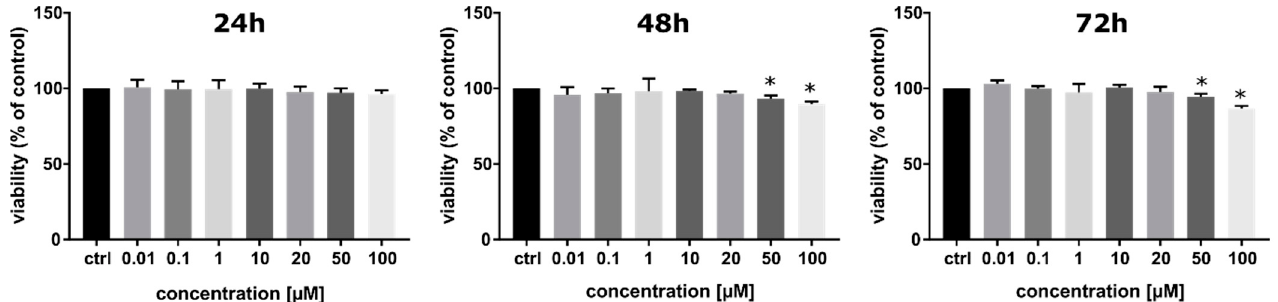
Figure 1. Viability of PC3 cells after 24, 48, and 72 h of incubation with SCNdU in the concentration range from 0.01 µ M to 100 µ M. The results are shown as the mean ± SD of three independent experiments performed in triplicate. * A statistically significant difference ( p < 0.05) is present between the treated samples and control (an untreated